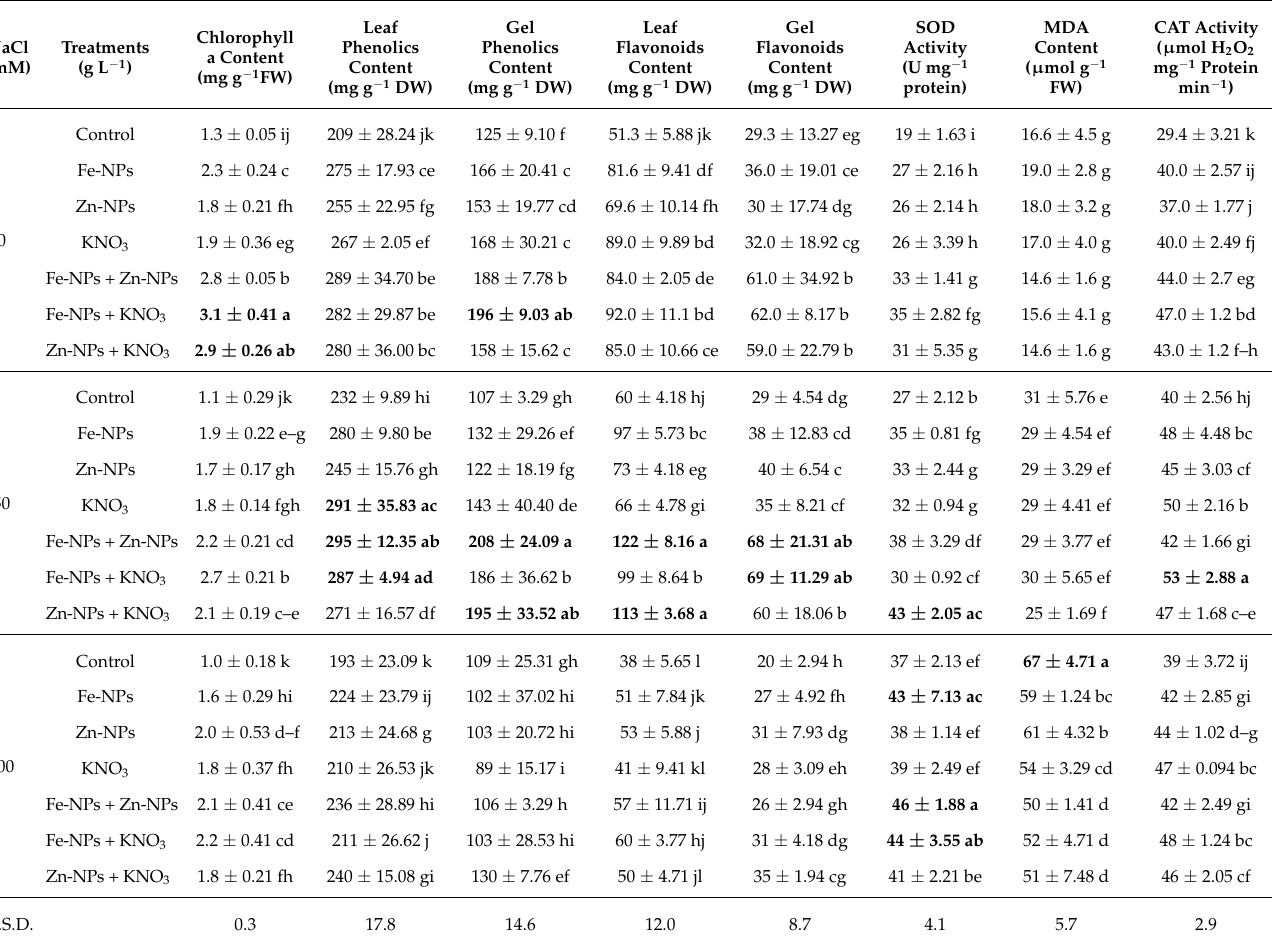
Different letters within each column indicate significant differences based on LSD test ( p < 0.05), and the bold data are the treatments that received the significance level of a.